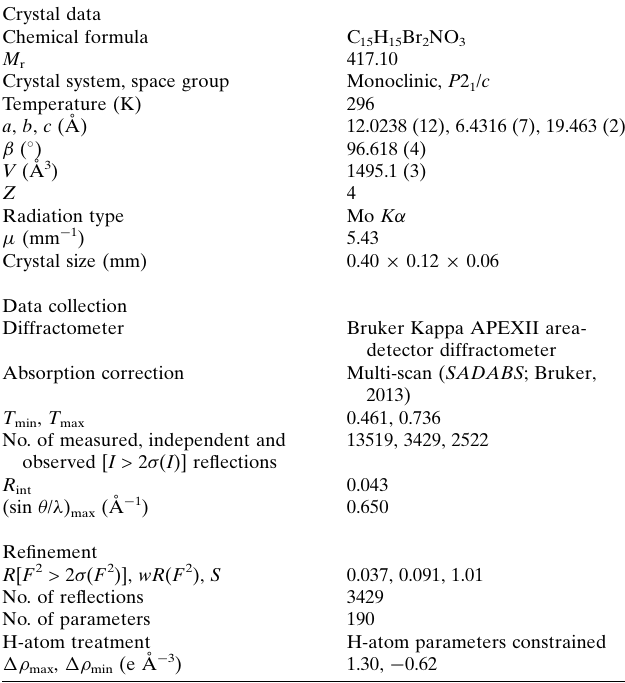
Table 2 Summary of shortest van der Waals contacts (A˚ ) in the title compound. Contact Distance